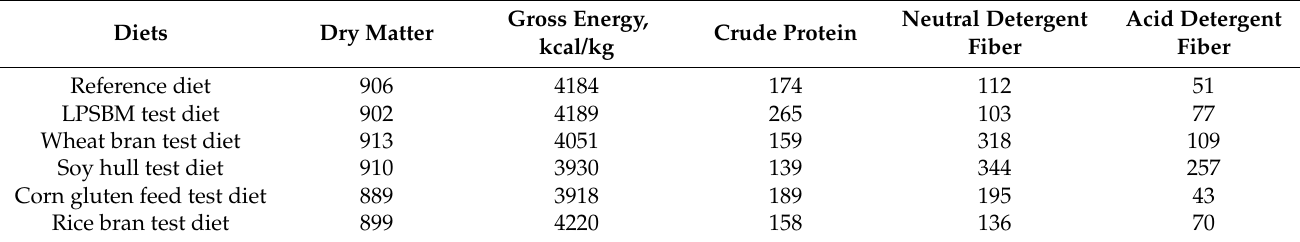
Table 3. Analyzed composition (g/kg, as fed basis) of the experimental